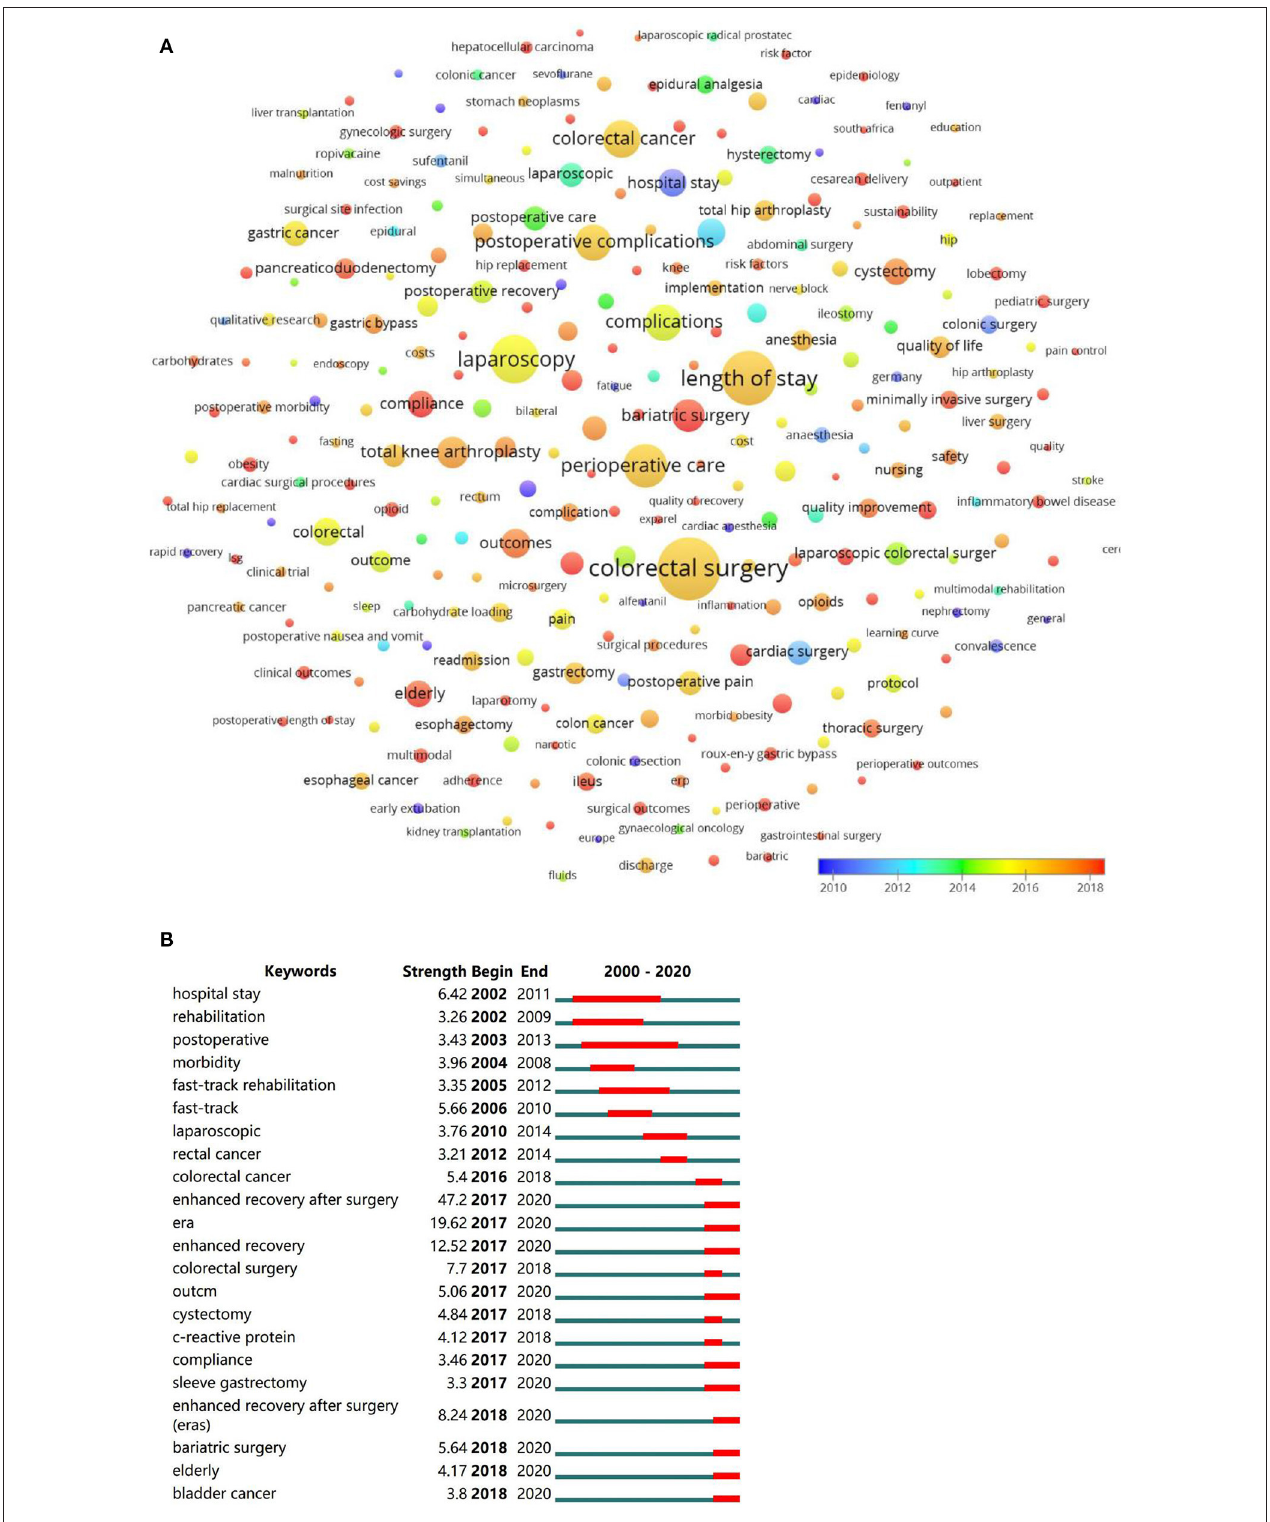
FIGURE 7 | Visualized analysis and burst detection of author keywords. (A) Co-occurrence analysis of author keywords, weighed by average occurred year. (B) The burst detection of keywords.